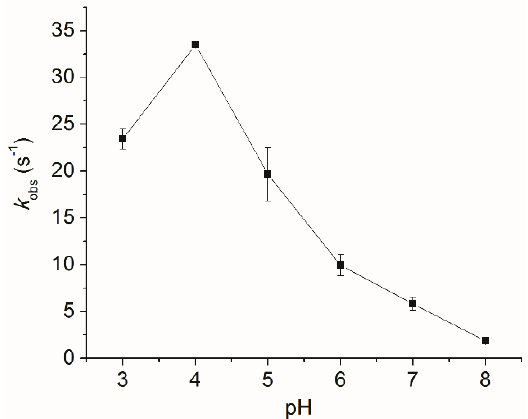
Figure 2. The effect of pH on the observed rate ( k obs ) of oxidation of ABTS by Pf DyP B2.